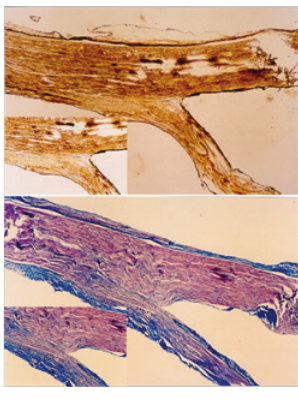
FIGURE 6 – Photomicrographs of the N2 nervous segment (original magnification 37x and 73x). (Above) N2, end-to-side neurorrhaphy stained by the Bielschowsky method. Numerous nerve fibers were seen within the graft, which demonstrates nerve fibers sprouting. (Below) N2 stained with trichromic Masson showed epineural discontinuity at the end-to-side